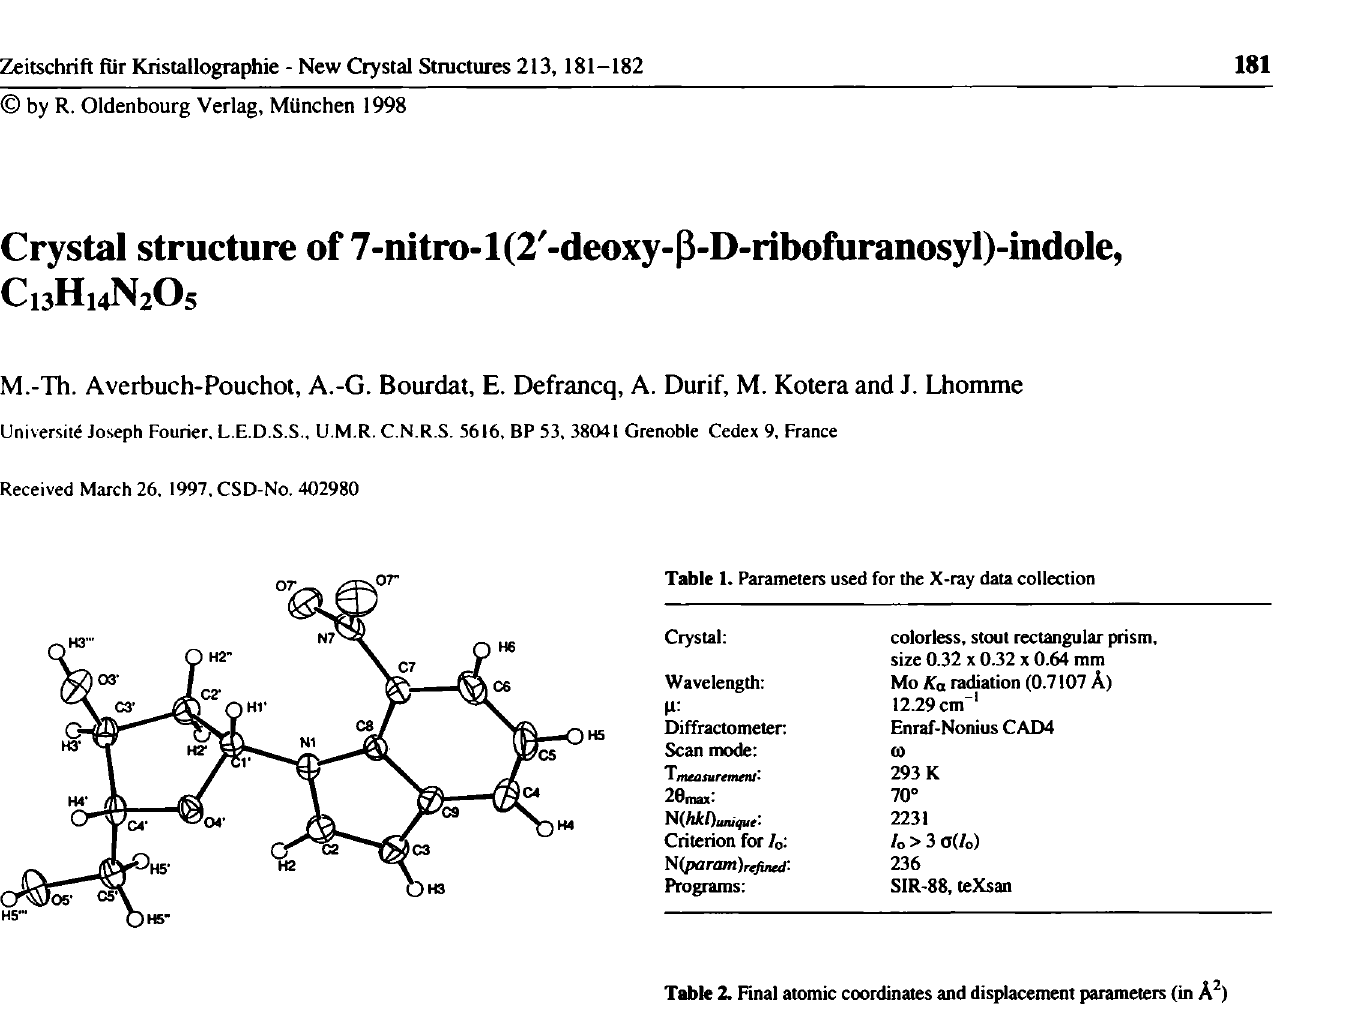
Table 3. Final atomic coordinates and displacement parameters (in Â^) Atom